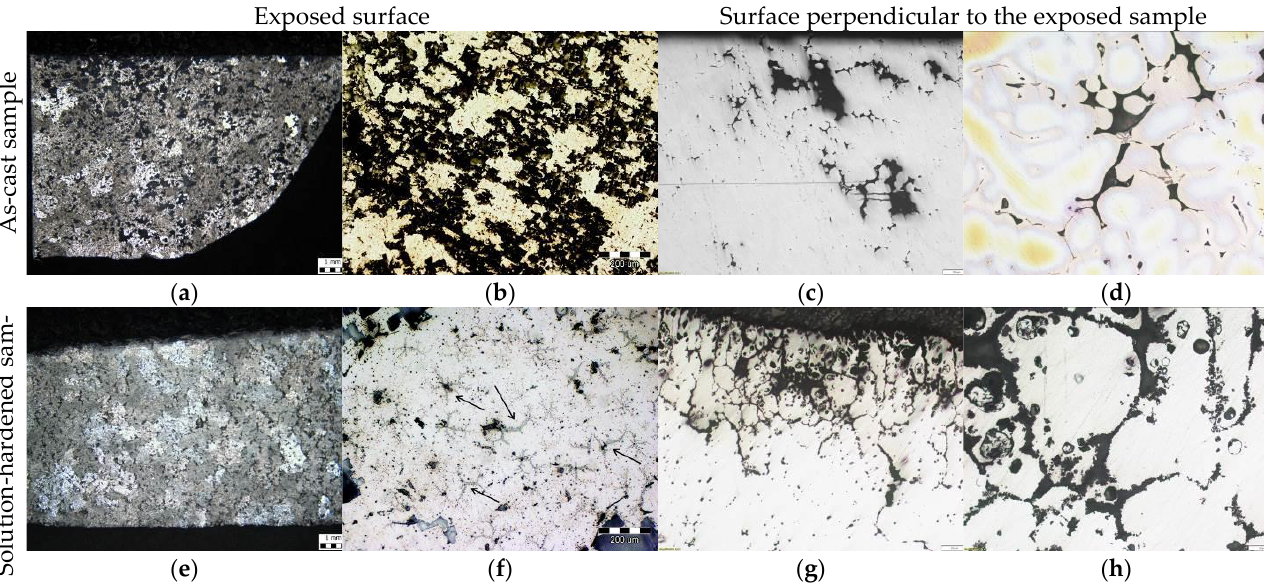
Figure 9. The structure of the samples after electrochemical testing: ( a ) macrostructure of the exposed surface of the as-cast sample; ( b ) microstructure of the exposed surface of the as-cast sample; ( c ) microstructure of the perpendicular surface of the as-cast sample; ( d ) phase involvement; ( e ) macrostructure of the exposed surface of the solution-hardened sample; ( f ) microstructure of the exposed surface of the solution-hardened sample; ( g ) microstructure of the perpendicular surface of the solution-hardened sample; ( h ) phase involvement and dissolution of the α Al matrix.